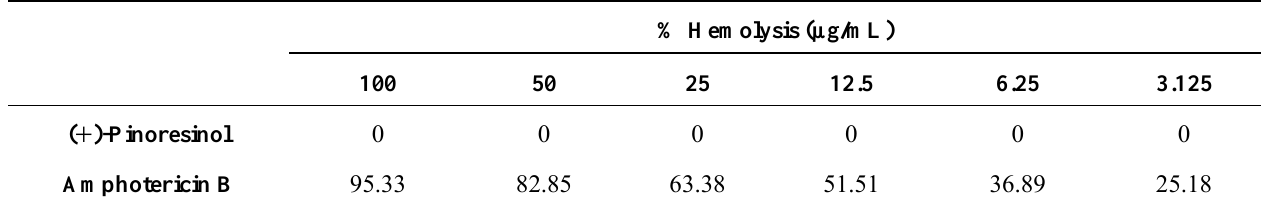
Table 3. Hemolytic activity of ( + )-pinoresinol against human